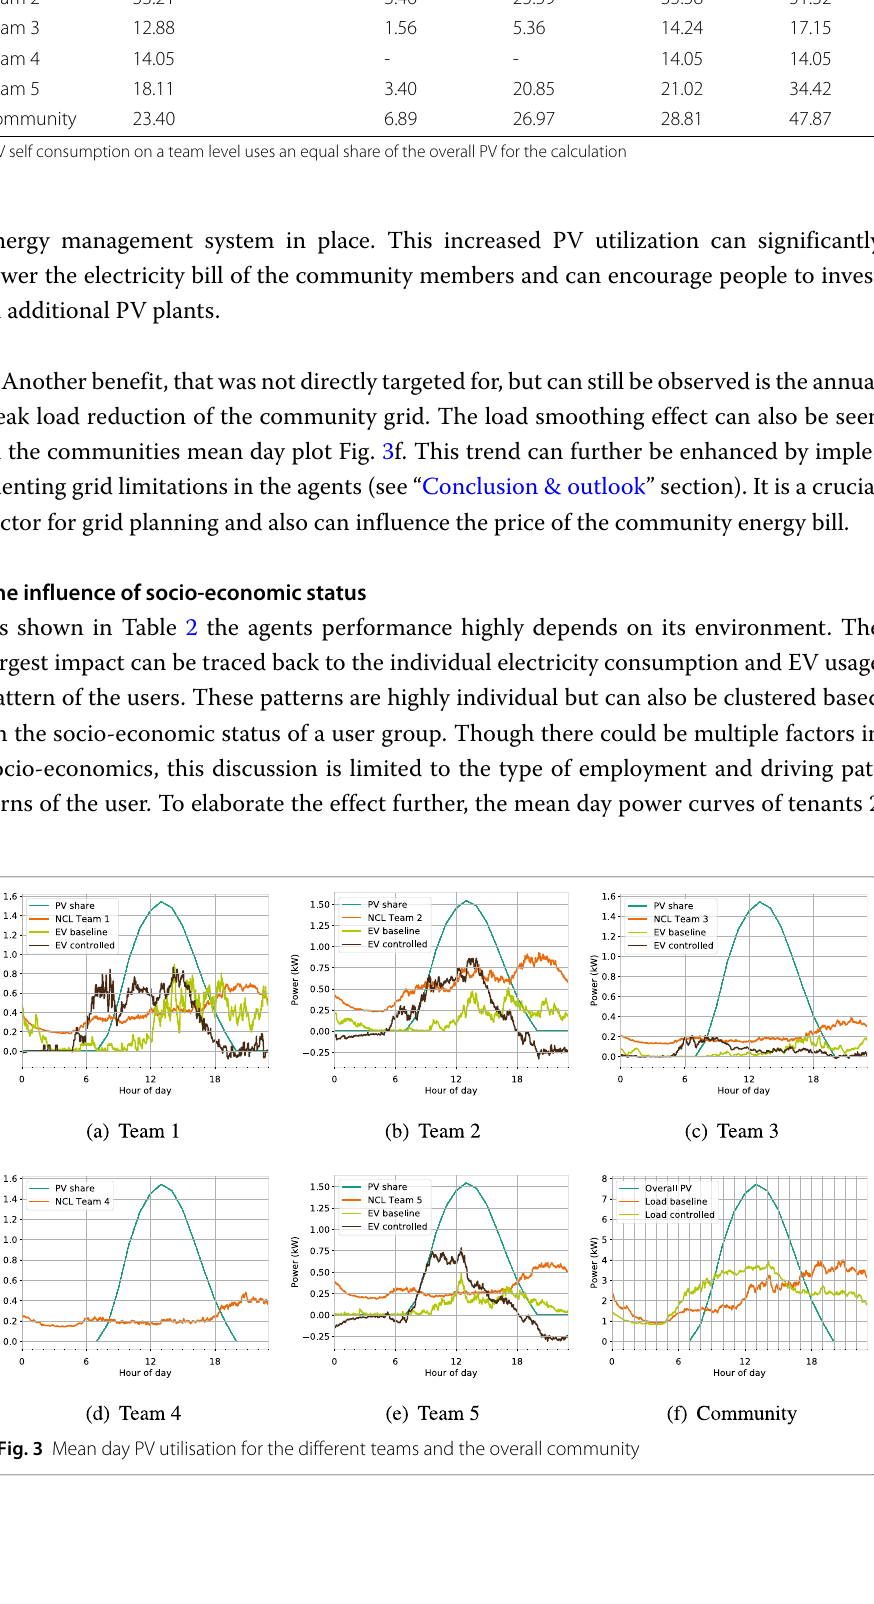
Table 2 PV Self Consumption* in percentage (%) EV Overall Non controllable loads Baseline Controlled Baseline Controlled 24.60